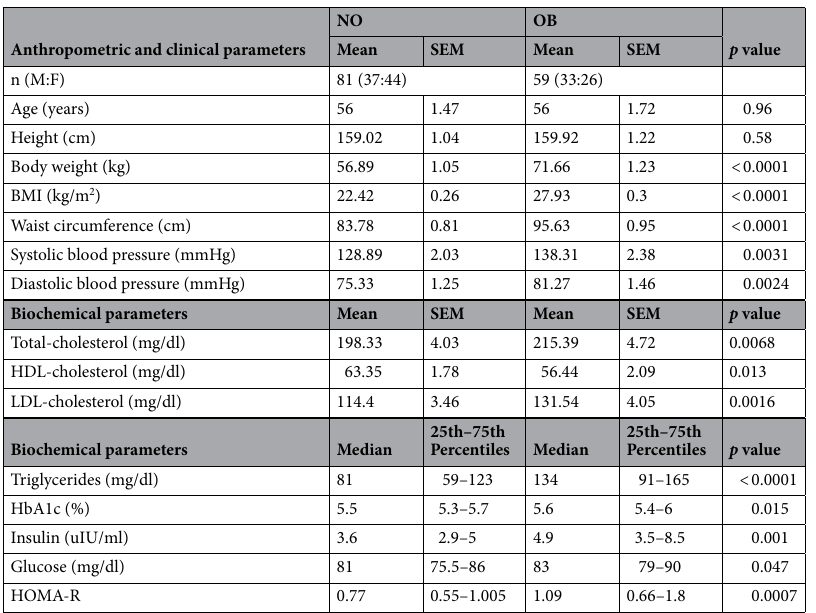
Table 1. Characteristics of NO and OB. Data were analyzed using unpaired t -test or Mann–Whitney U test to compare groups. NO non-obese, OB obese.